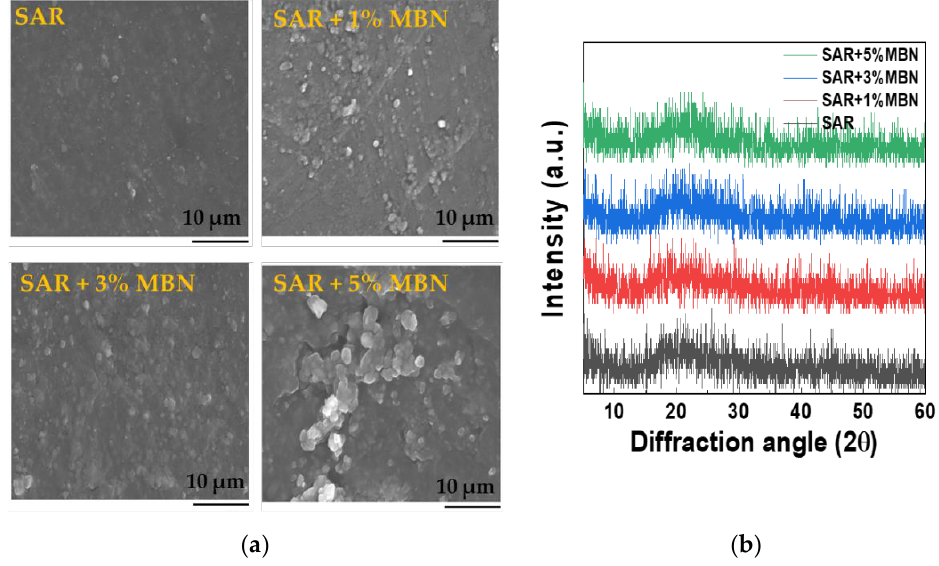
Figure 3. ( a ) FT-IR spectra; ( b ) XRD pattern; and ( c ) TEM image of the synthesized MBN. Figure 4 shows the surface images of SAR and MBN contained in the SAR resin discs. For the SAR + 5%MBN disc, MBN particles agglomerated in the resin structure. In the XRD patterns, all samples with different amounts of MBNs revealed an amorphous phase.